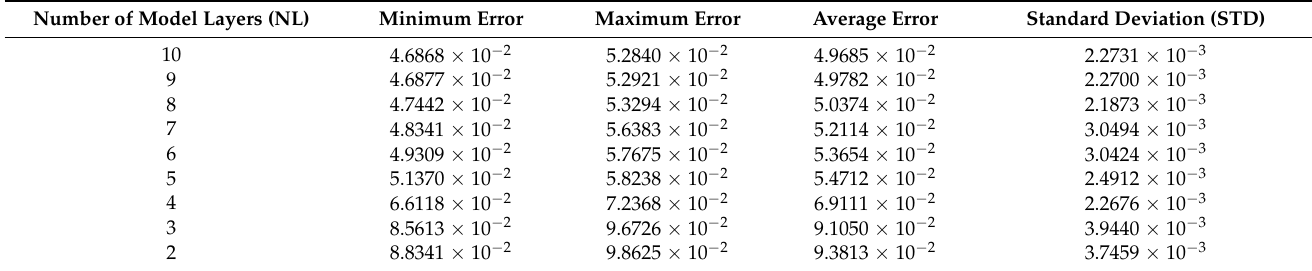
Table 1. Statistical analysis of the error for optimization of the initial drug concentration (Case